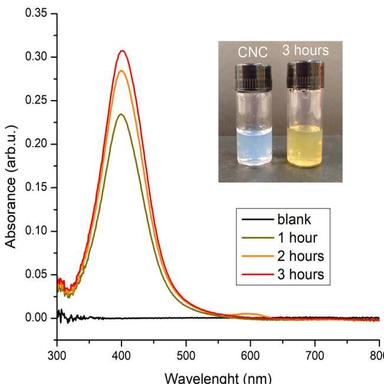
UV–vis spectra showing the CNC-Ag formation over time. The vials show the change in color that occurs after the CNC-Ag formation (yellow). (For interpretation of the references to color in this figure legend, the reader is referred to the web version of this article.)